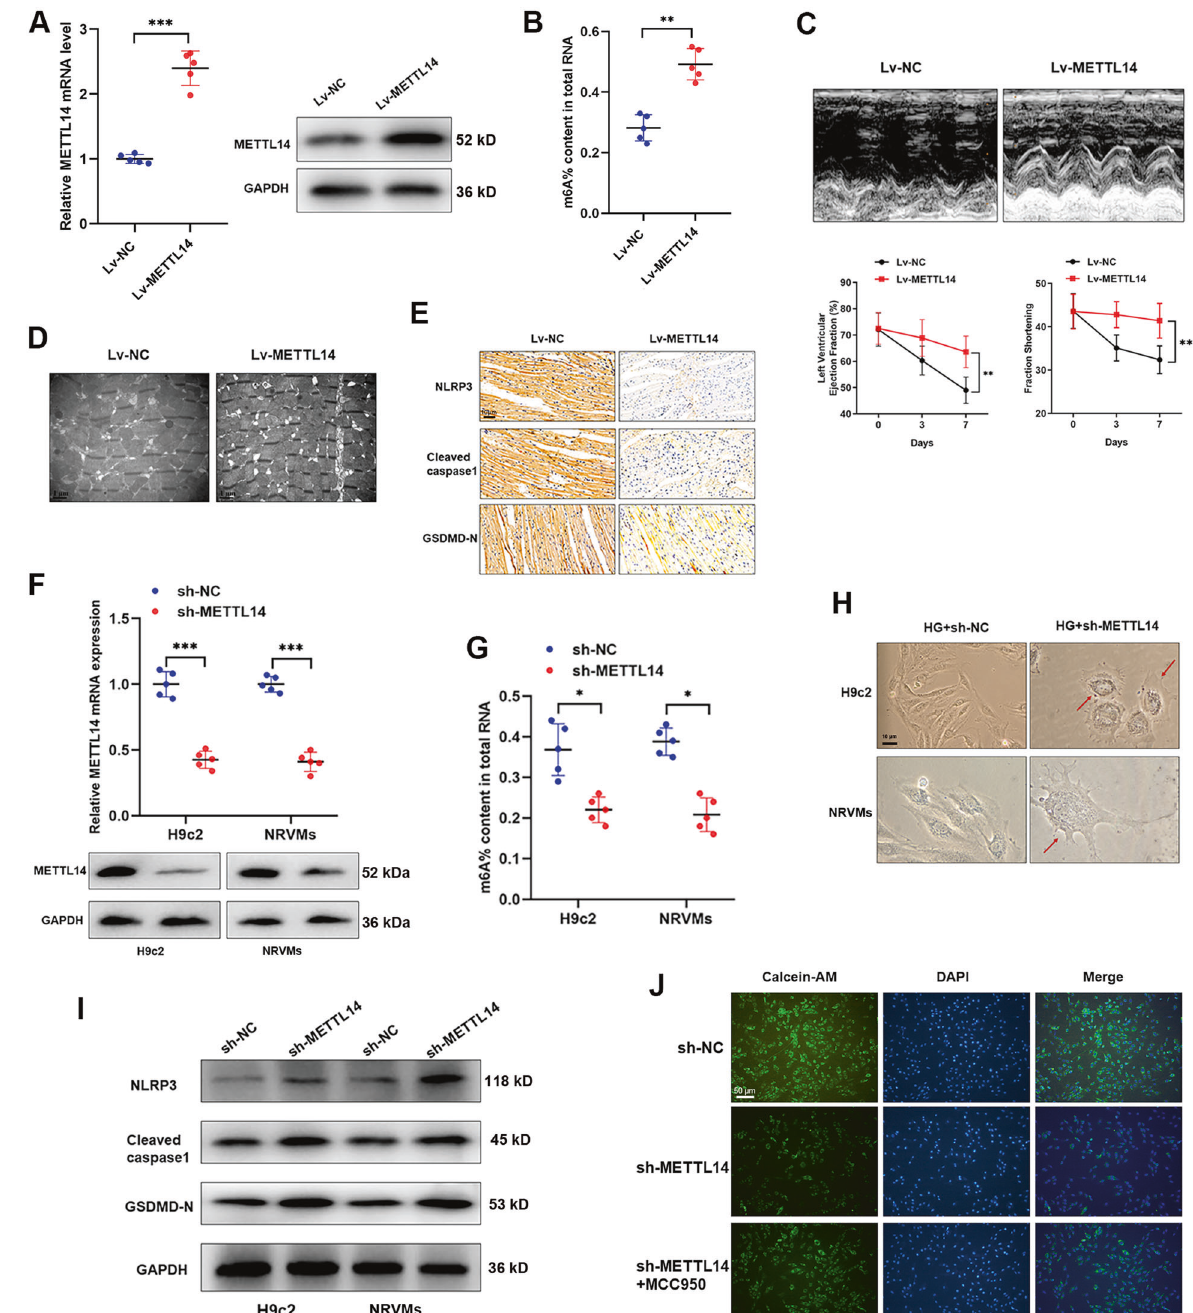
Fig. 4 METTL14 suppresses DCM via modulating pyroptosis. A Validation of METTL14 overexpression in DCM rats by western blot and qRT- PCR, *** P < 0.001. B The overall m6A content was increased by upregulation of METTL14, ** P < 0.01. C Morphological changes (upper panel) and quantitative analysis of LVEF and FS (lower panel) in rat hearts were detected by echocardiography after injection of METTL14 overexpression vector, ** P < 0.01. D Electron microscopy imaging of cardiomyocyte ultrastructure showed that rats overexpressed with METTL14 showed decreased cardiomyocyte damage compared to control group. E IHC analysis of pyroptosis-related proteins in DCM rats overexpressed METTL14. F Con fi rmation of silence of METTL14 in cardiomyocytes at both transcript and protein levels, *** P < 0.001. G knockdown of METTL14 caused signi fi cantly downregulated m6A modi fi cation level, * P < 0.05. H Morphologic changes of HG-treated cardiomyocytes upon knockdown of METTL14. I Western blot experiment was carried out to reveal the expression changes of pyroptosis- related proteins in cardiomyocytes transfected with METTL14 silencing vectors. J Calcein-AM staining showed that deletion of METTL14 increased membrane rupture of cardiomyocytes, however, this effect was reversed by treatment with MCC950.